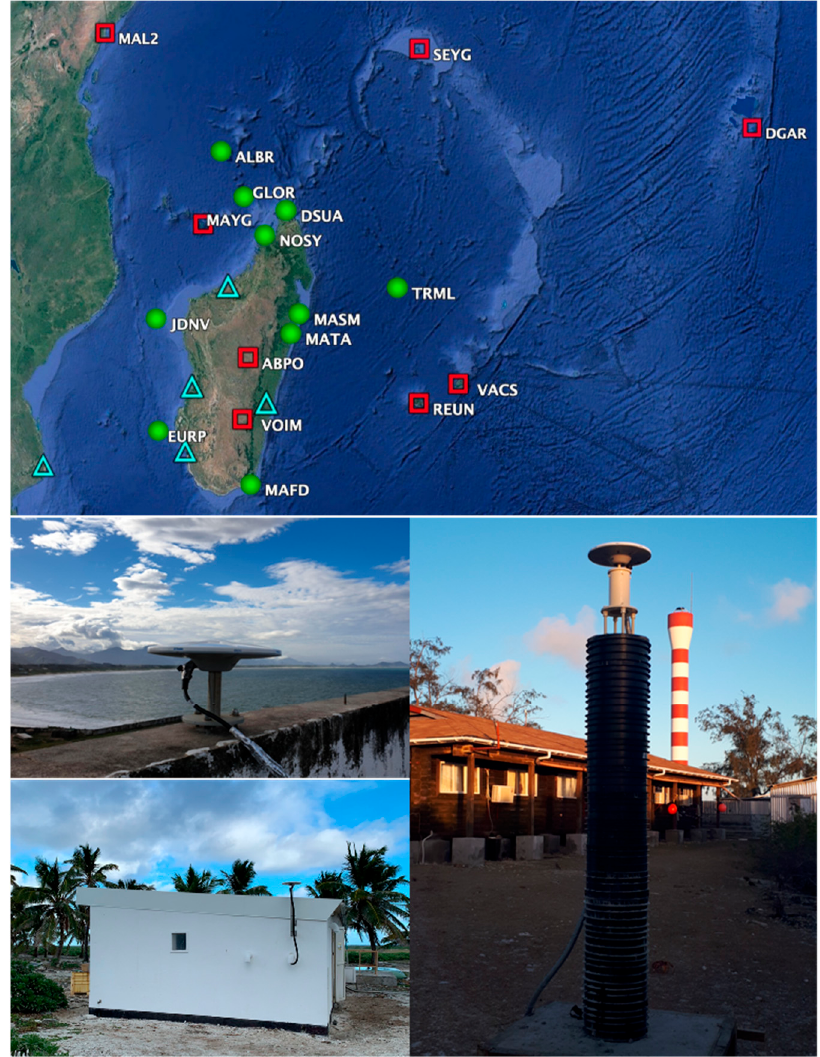
Figure 21. Map of public GNSS stations available in the SWIO as of March 2021 (top). Red squares show current IGS stations, green dots show GNSS stations installed during RNR-CYC, and blue triangles show stations to be installed in 2021 in the frame of the new project ESPOIRS (see Section 4). Pictures show GNSS stations installed in Fort-Dauphin (MAFD, upper-left), Tromelin (TRML, lower-left) and Aldabra (ALBR, lower-right). Sources: Google Earth (top); Olivier Bousquet (pictures)